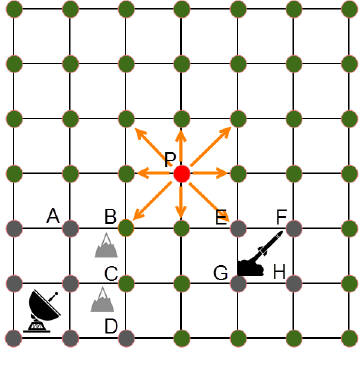
Figure 8. Space division.